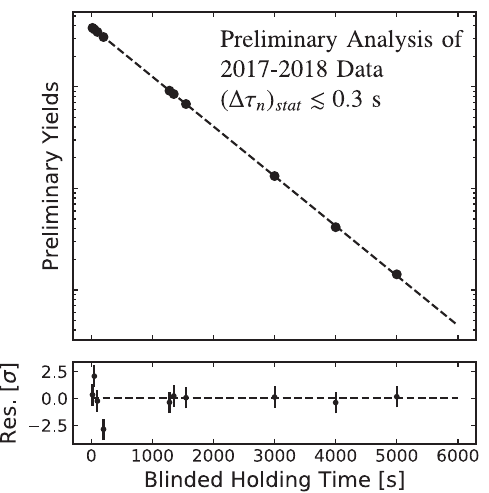
Figure 5. Preliminary analysis of the blinded 2017–2018 data including holding times of 5000 s is shown in the top panel. The dashed line represents a single-exponential two-parameter fit, normalization and lifetime (statistical errorbars are smaller than the markers). In the bottom panel the normalized residuals to the fit are shown where the errorbars are 1 σ stat and the dashed line represents